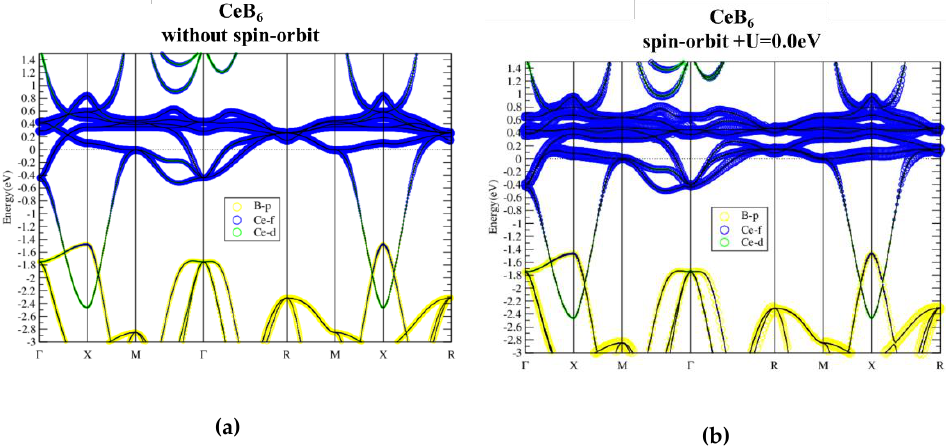
Figure 4. Band structure of CeB 6 without ( a ) and with ( b ) spin–orbit interaction.